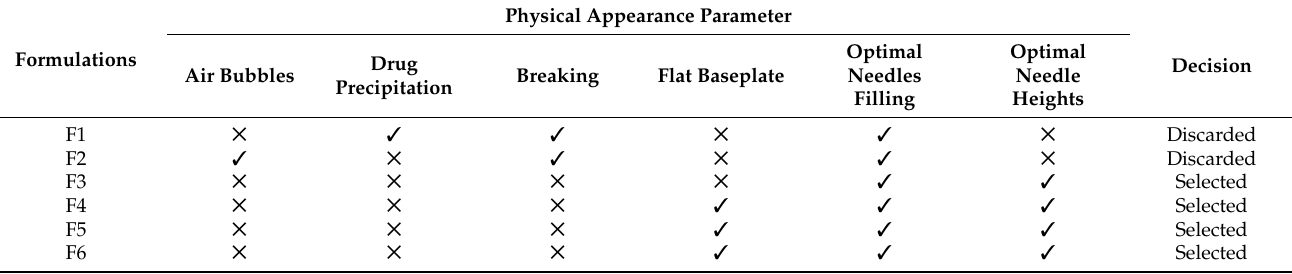
Table 2. Summary of Physical